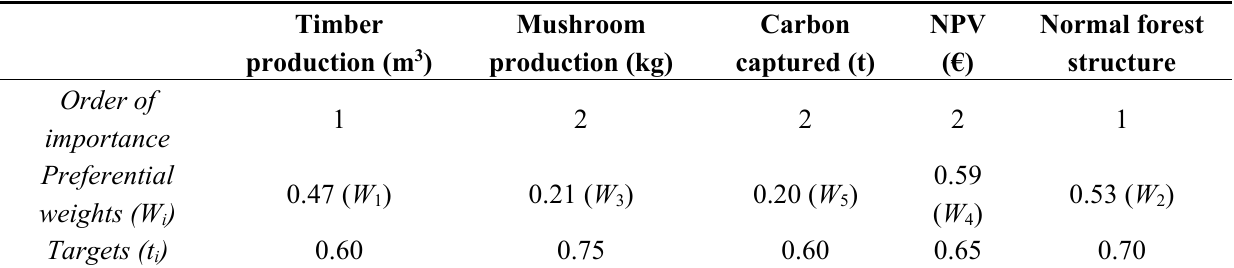
Table 3. Stakeholders survey results.